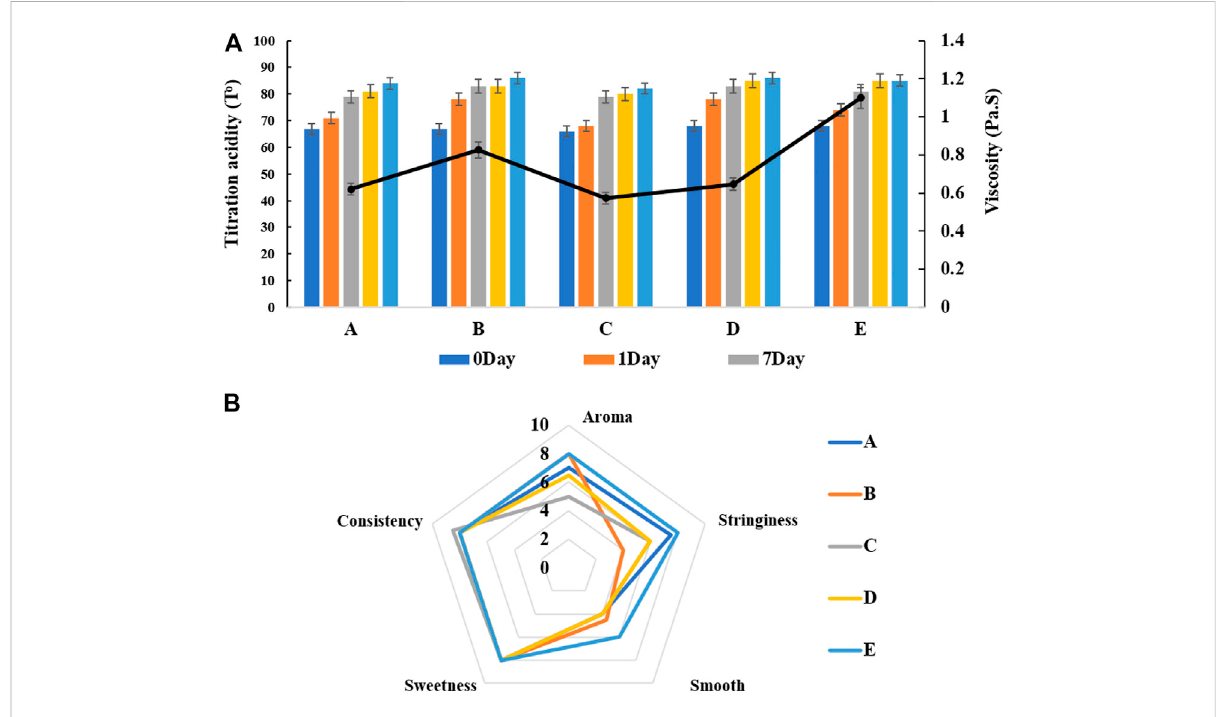
Theviscosity,post-acidi fi cation (A) andsensoryevaluation (B) offermentedmilkproducedbydifferentmixedstrainscompounds.AST53:ST49: ST50 = 1:1:1 B ST53:ST49:ST50 = 1:3:2 C ST53:ST49:ST50 = 3:1:2 D ST53:ST49:ST50 = 2:2:1 E ST53:ST49:ST50 =